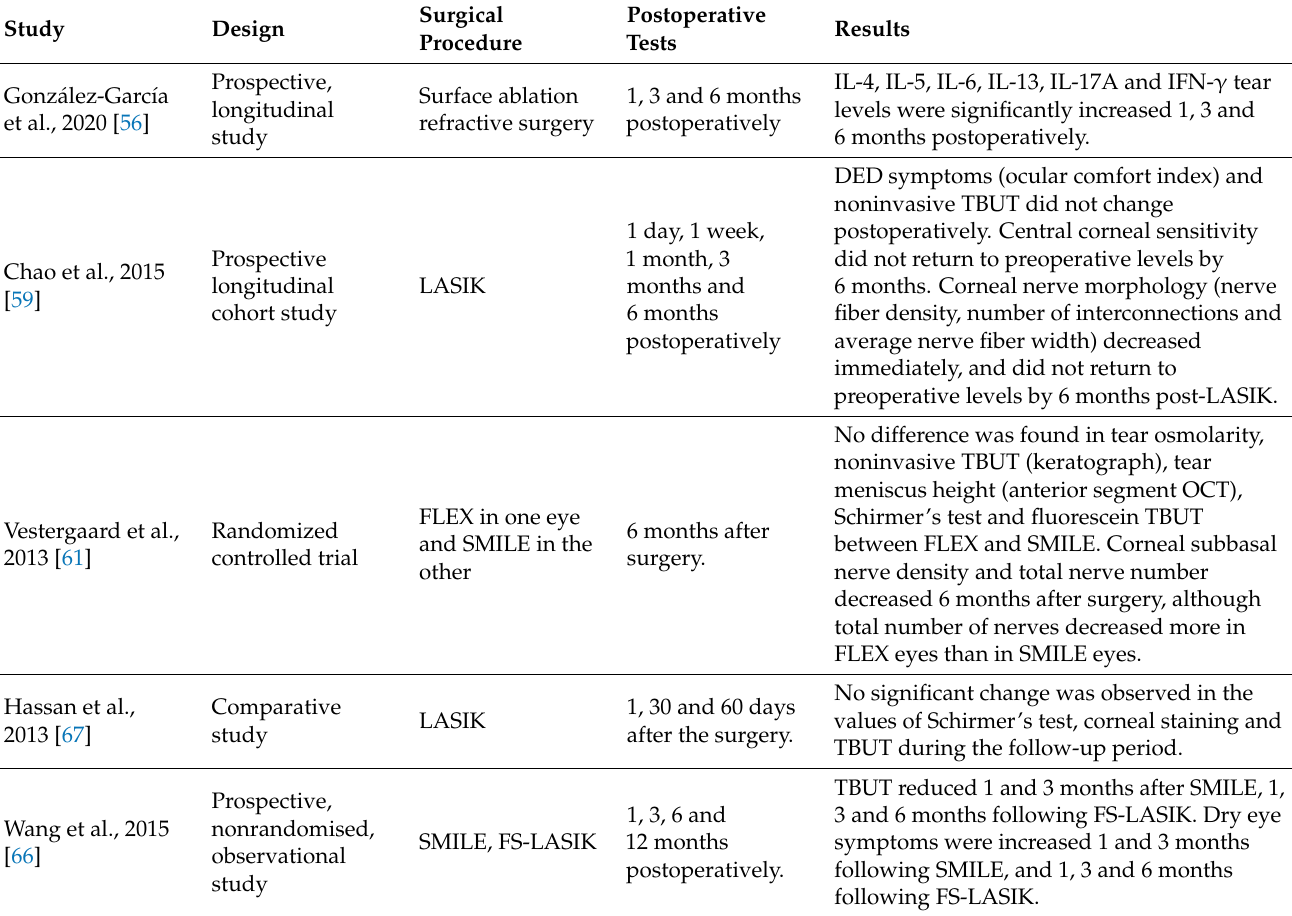
Table 2. Ocular surface dysfunction after refractive eye